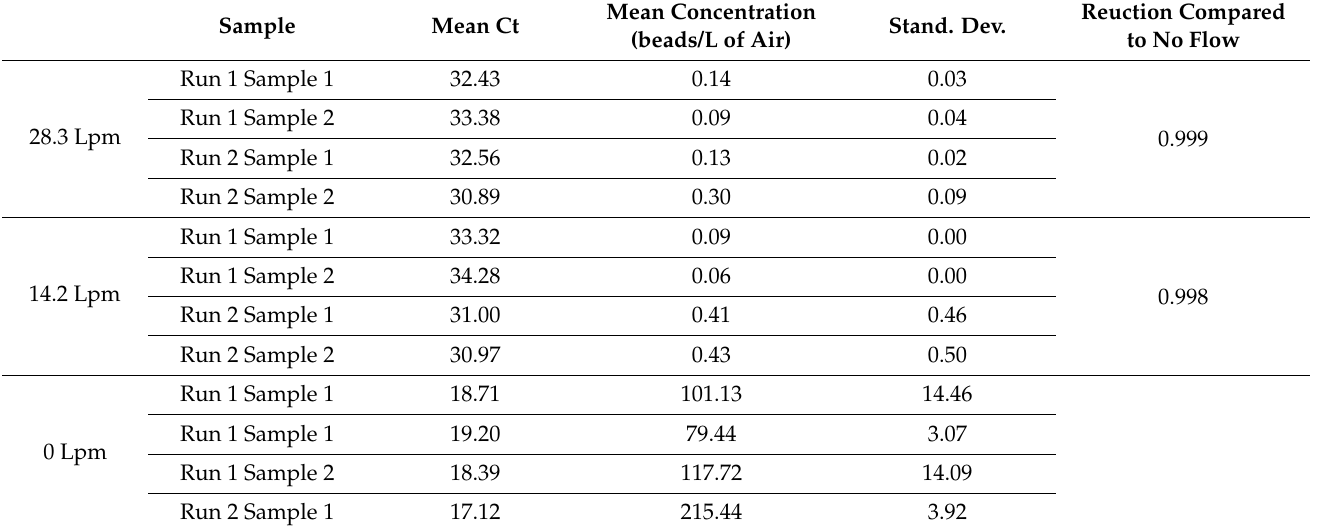
Table 2. Results of preliminary evaluation of IACM with DNA-tagged PSL beads.